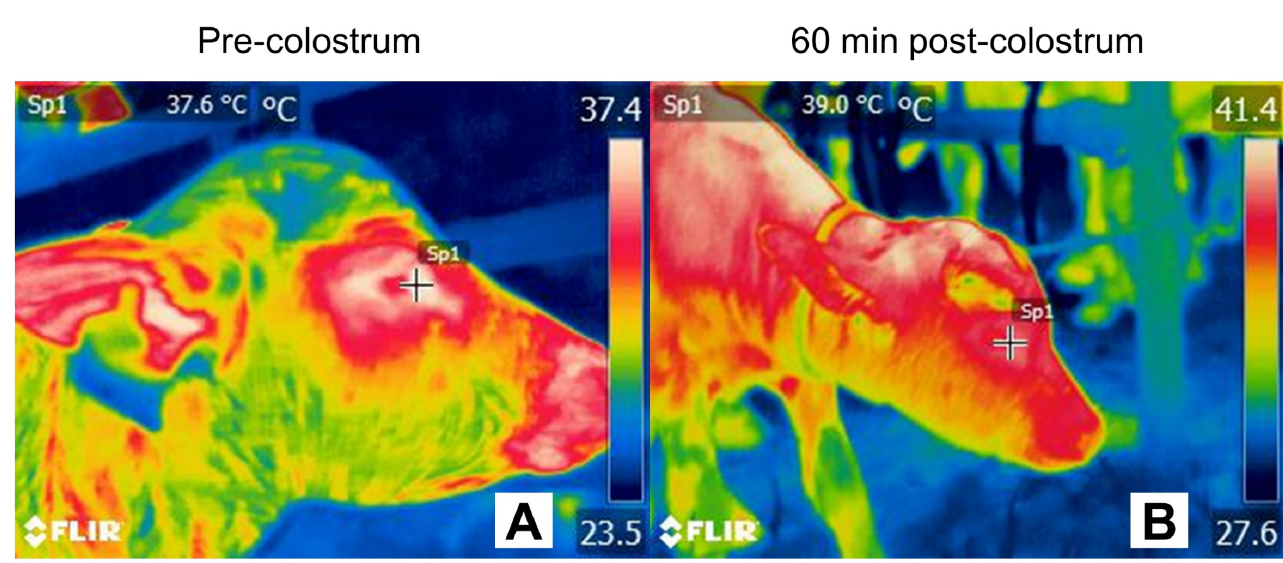
Figure 5. Effect of colostrum on thermoregulation in the newborn calf ( Bubalus bubalis ). ( A ) Lateral facial thermogram of a calf before receiving colostrum. The temperature assessed at the lacrimal caruncle shows an average value of 37.6 °C. In contrast ( B ), 60 min post-colostrum intake, the same thermal window has an average temperature of 39.0 °C. This represents a gain of 1.2 °C after feeding and rapid obtainment of available energy resources in colostrum. +Sp1: default focal point of the software. Thermal images obtained using a FLIR thermal camera.